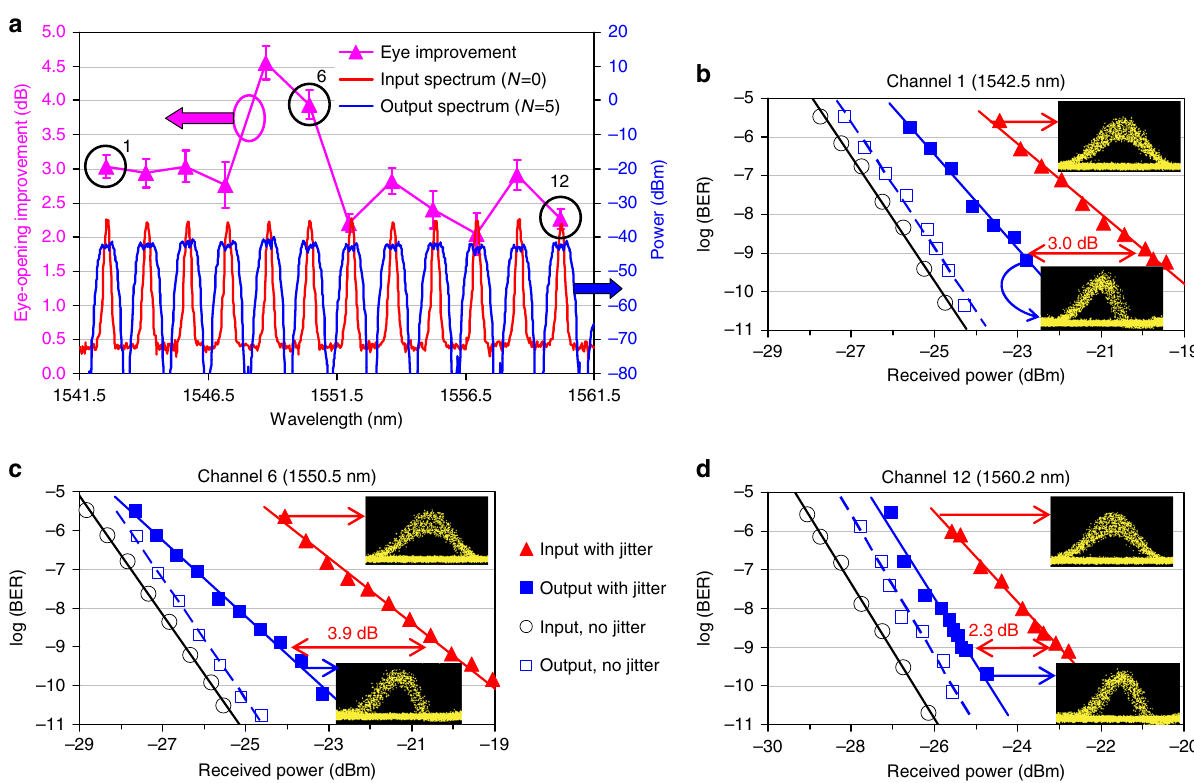
Fig. 4 Results of 12-channel 2R regeneration in the recirculating loop. a Eye-opening improvements at BER = 10 − 9 for 12 simultaneously regenerated channels ( left axis ); 12-channel spectra at the input ( blue ) and output ( red ) of the regenerator ( right axis ), obtained with the resolution bandwidth of 0.1 nm. N is the number of circulations. Error bars are obtained from the linear fi ts to BER curves. Numbered circles indicate the channels shown in b – d . b – d BER curves and eye diagrams for amplitude-jitter-degraded signals before ( red triangles ) and after the regeneration ( blue squares ) for 1542.5-nm ( b ), 1550.5-nm ( c ) and 1560.2-nm ( d ) channels. BERs for signals without amplitude jitter are also shown ( black open circles — before and blue open squares — after the regeneration). b – d Share common legend. The eye diagrams (insets in b – d ) exhibit signi fi cant reduction in the amplitude jitter after the